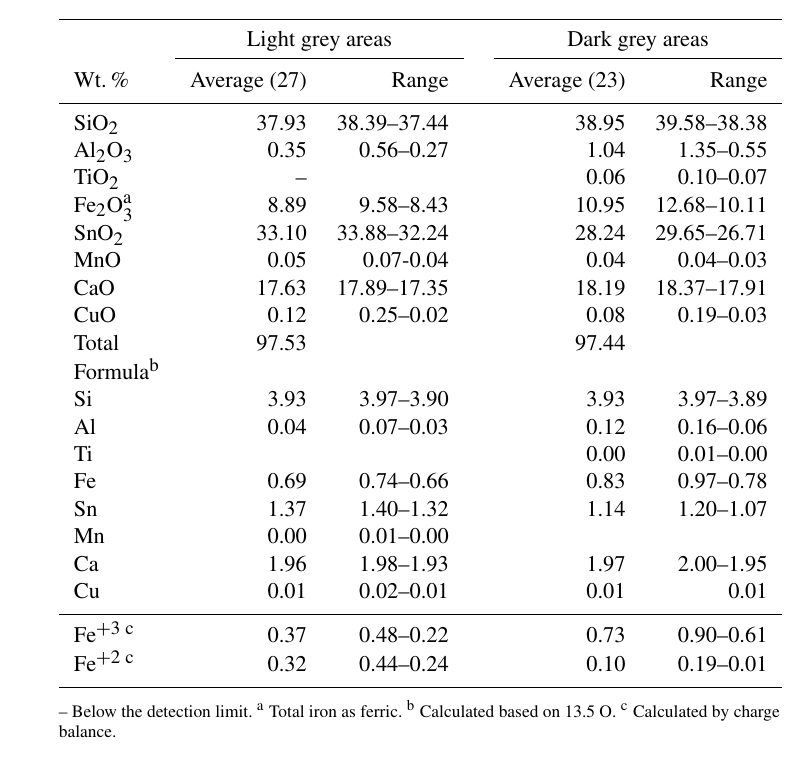
Table 1. Electron microprobe analyses of silesiaite (number of analyses in brackets).